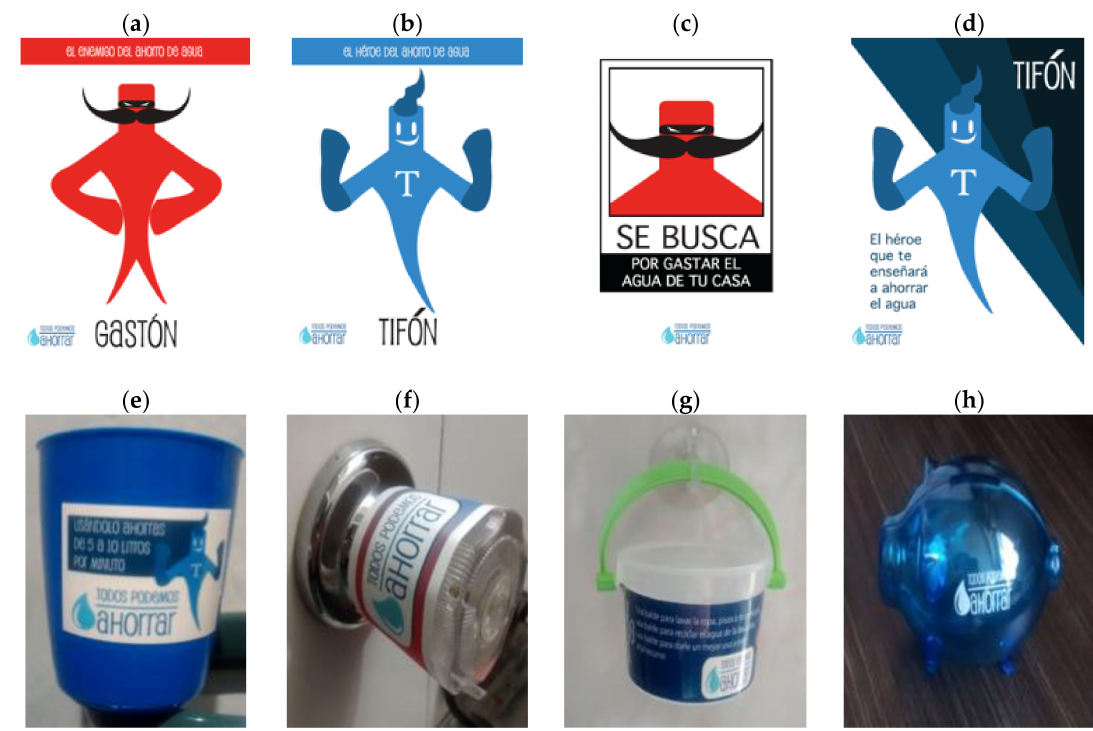
Figure 3. Examples of stickers ( a – f ) and plastic elements ( g , h ) that were distributed among